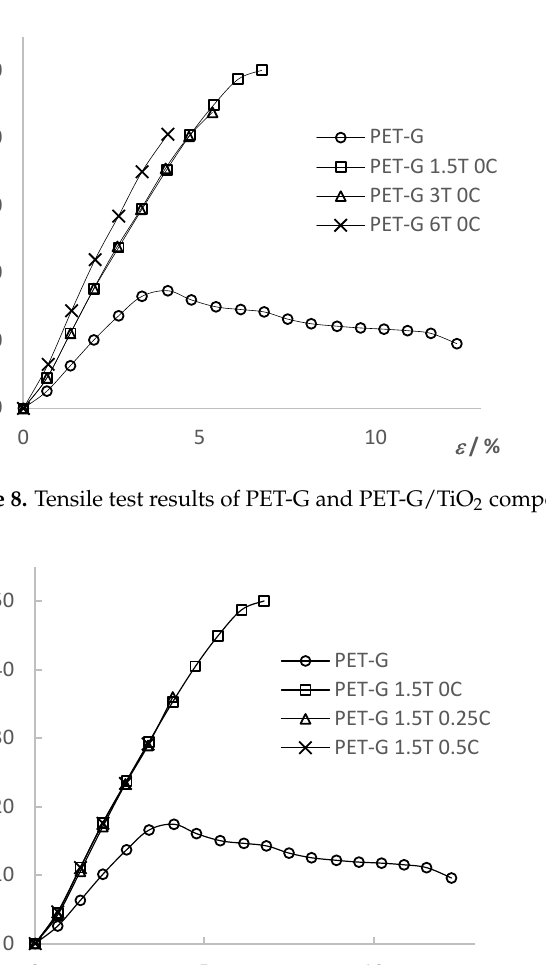
Figure 8. Tensile test results of PET-G and PET-G/TiO 2 composites .